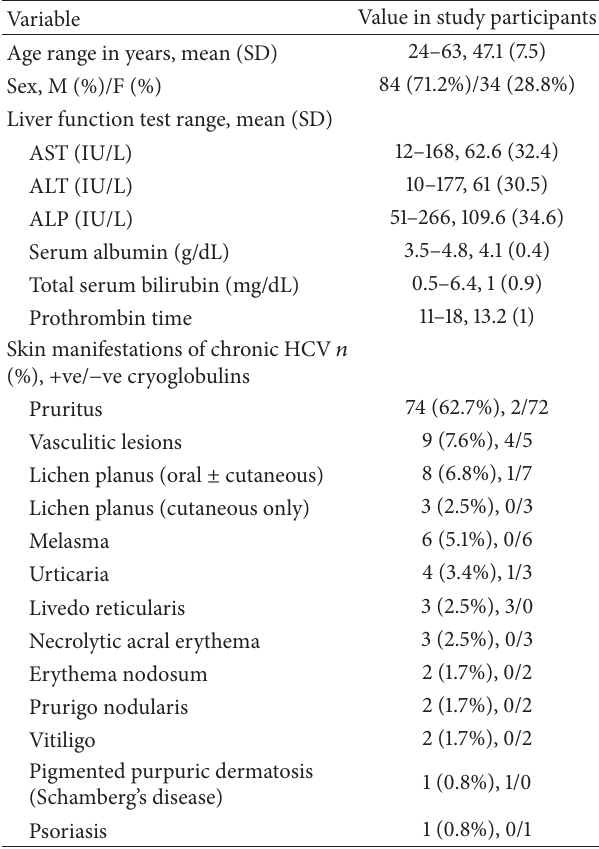
Table 1: Clinical and laboratory criteria of HCV infected patients with cutaneous manifestations ( 𝑛 = 118